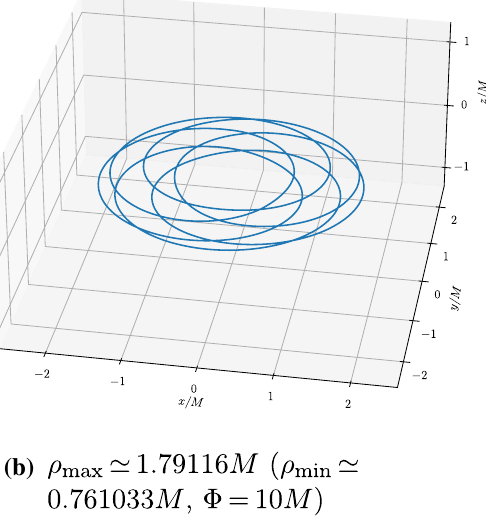
make (cid:9) equal to 10 M exactly. The orbits actually start at ρ min in both plots, and terminate after the interval (cid:10)φ = 6 π and 12 π ,